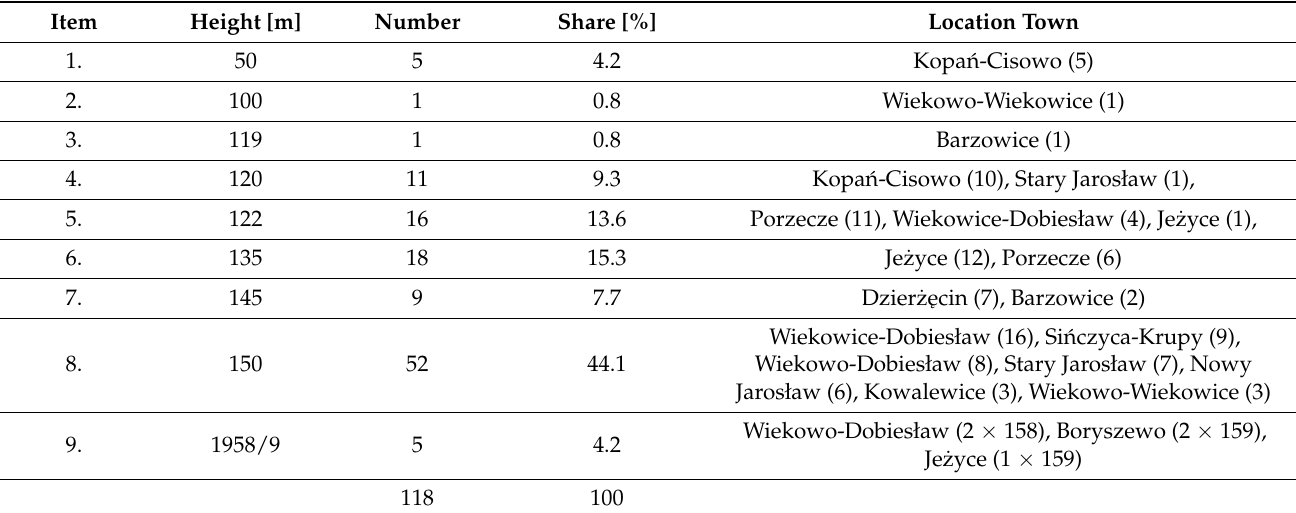
Table 3. Wind turbines with ‘exclusion zones’ defined around them in the Municipality of Darłowo, 2022 [59].